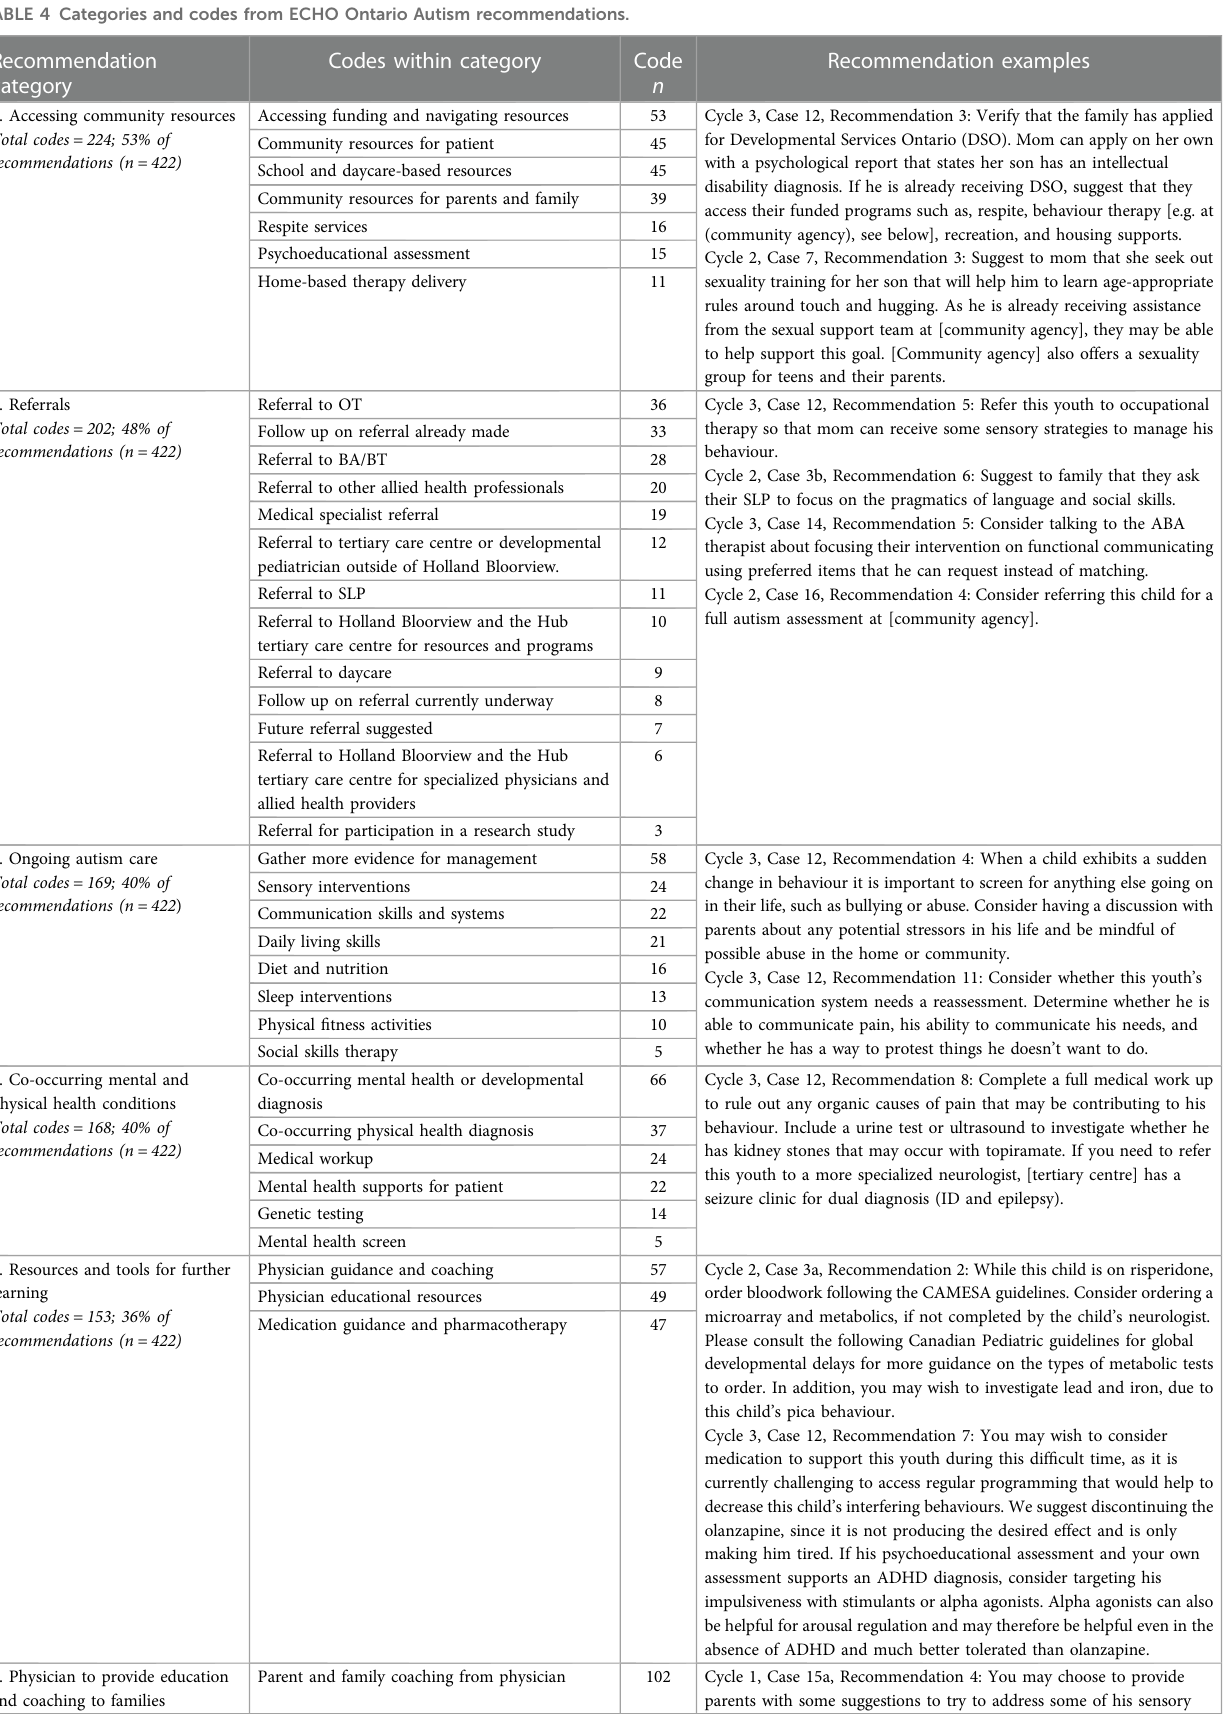
TABLE 4 Categories and codes from ECHO Ontario Autism